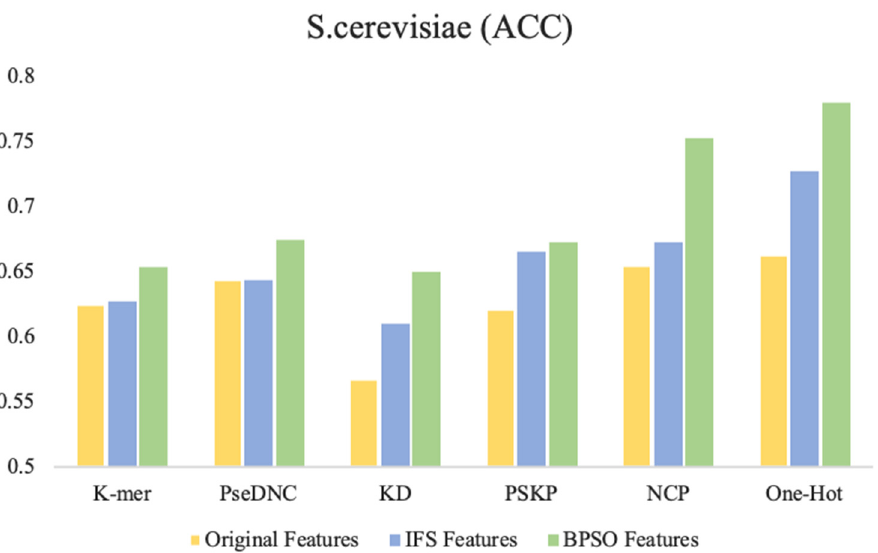
Figure 4. Comparison of performance between different feature selection methods and BPSO method. The Original Features represent all the features without feature selection, the IFS Features represent the optimal subset of features selected using incremental feature selection methods, and the BPSO Features represent the optimal subset of features selected using the binary particle swarm optimization algorithm.